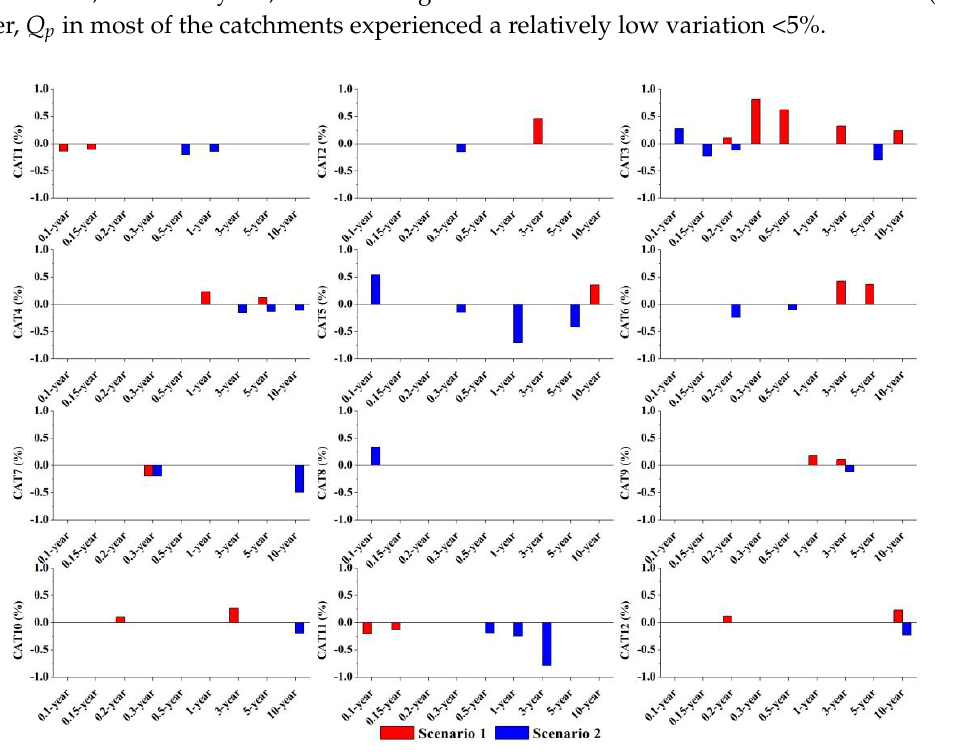
Figure 7. Variations in catchment total runoff depth ( Q t ) under different scenarios and rainfall conditions. X -axis represents different rainfall conditions assigned with return period; Y -axis represents the change rate in Q t (%) under the scenarios 1 and 2 compared with that in the base case.